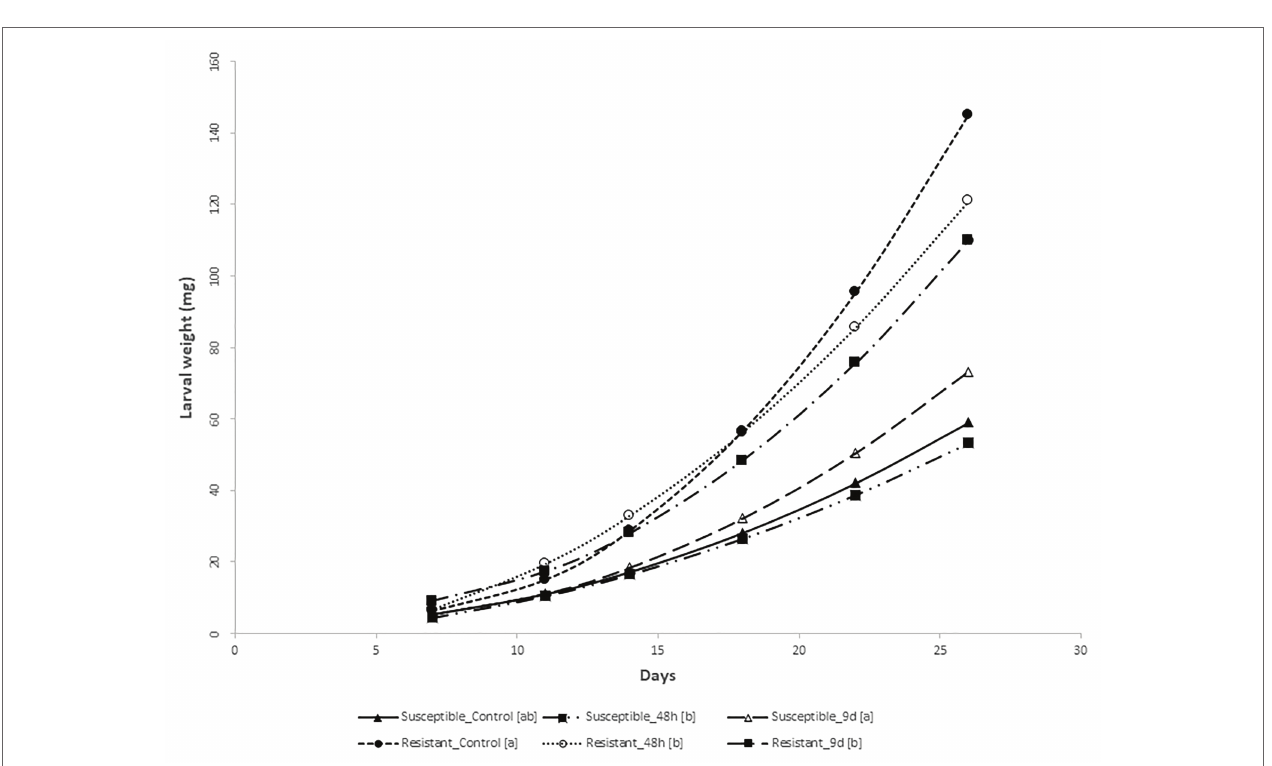
FIGURE 3 | MCB larval growth on non-choice feeding bioassay. Regression curves (including lineal and/or quadratic coefficients) of the weight (mg) of the MCB larvae fed on stems from the resistant and susceptible inbred plants pre-infested with MCB larvae for 48 h or 9 days (9 d) before or untreated (control) on time. Within each inbred, treatments followed by different letters within the brackets [] showed regression curves significantly different based on differences between linear or/and quadratic